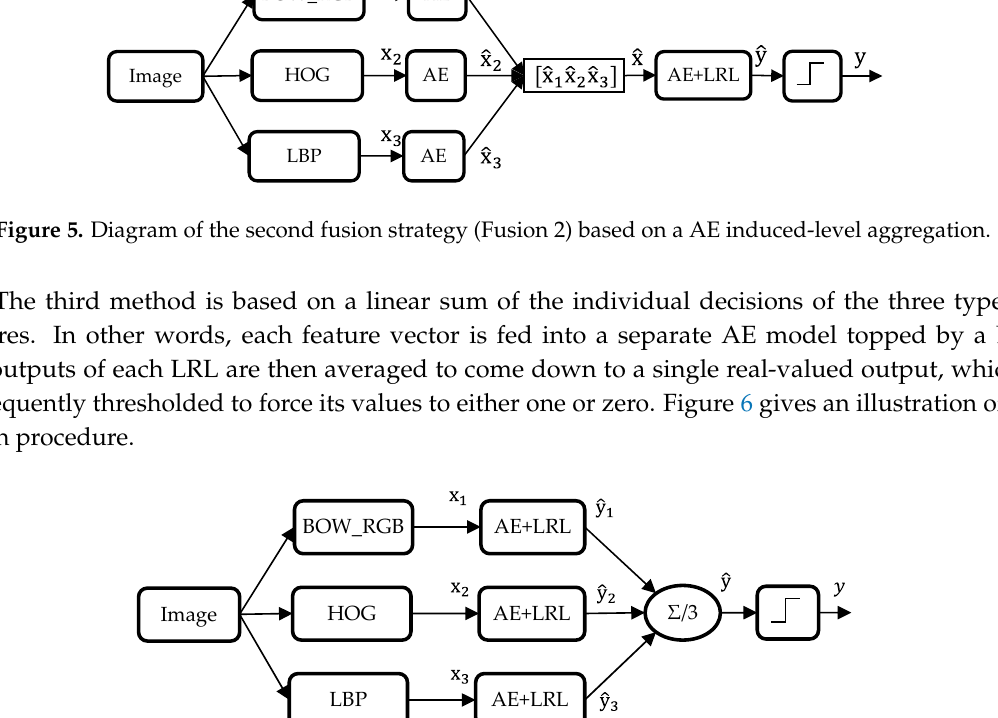
Figure 6. Diagram of the third fusion strategy (Fusion 3) based on a decision-level aggregation.